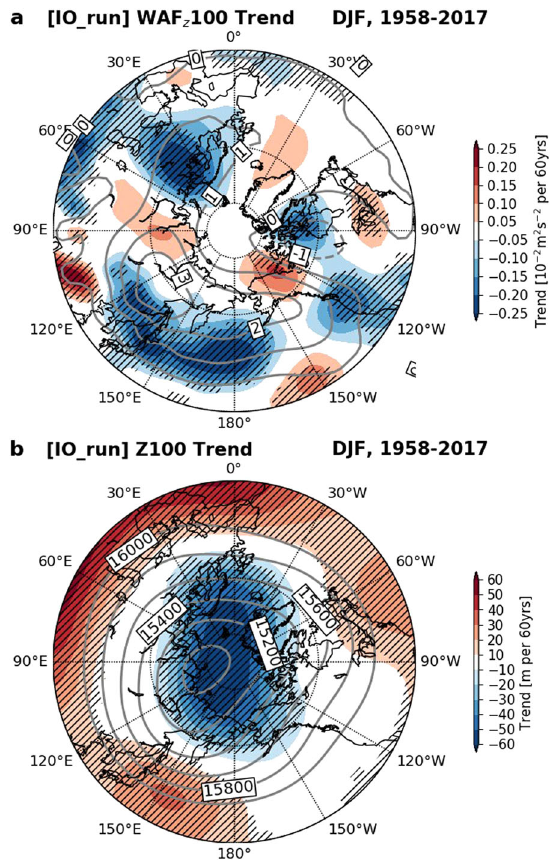
Fig. 6 Long-term trends of vertical wave activity fl ux and polar vortex in the IO_run. a The linear trend of vertical wave activity fl ux at 100hPa (WAF z 100) (shading) with the climatological (1958 – 2017) WAF z 100 (contour, unit: 10 − 2 m 2 s − 2 ) and ( b ) the linear trend of geopotential height at 100hPa (Z100) (shading) with the climatolo- gical Z100 (contour, unit: meter) in IO_run. The positive WAF z in Fig. 6a indicates the upward WAF z . The black hatched regions in Fig. 6a, b indicate statistically signi fi cant regions at a 95% con fi dence